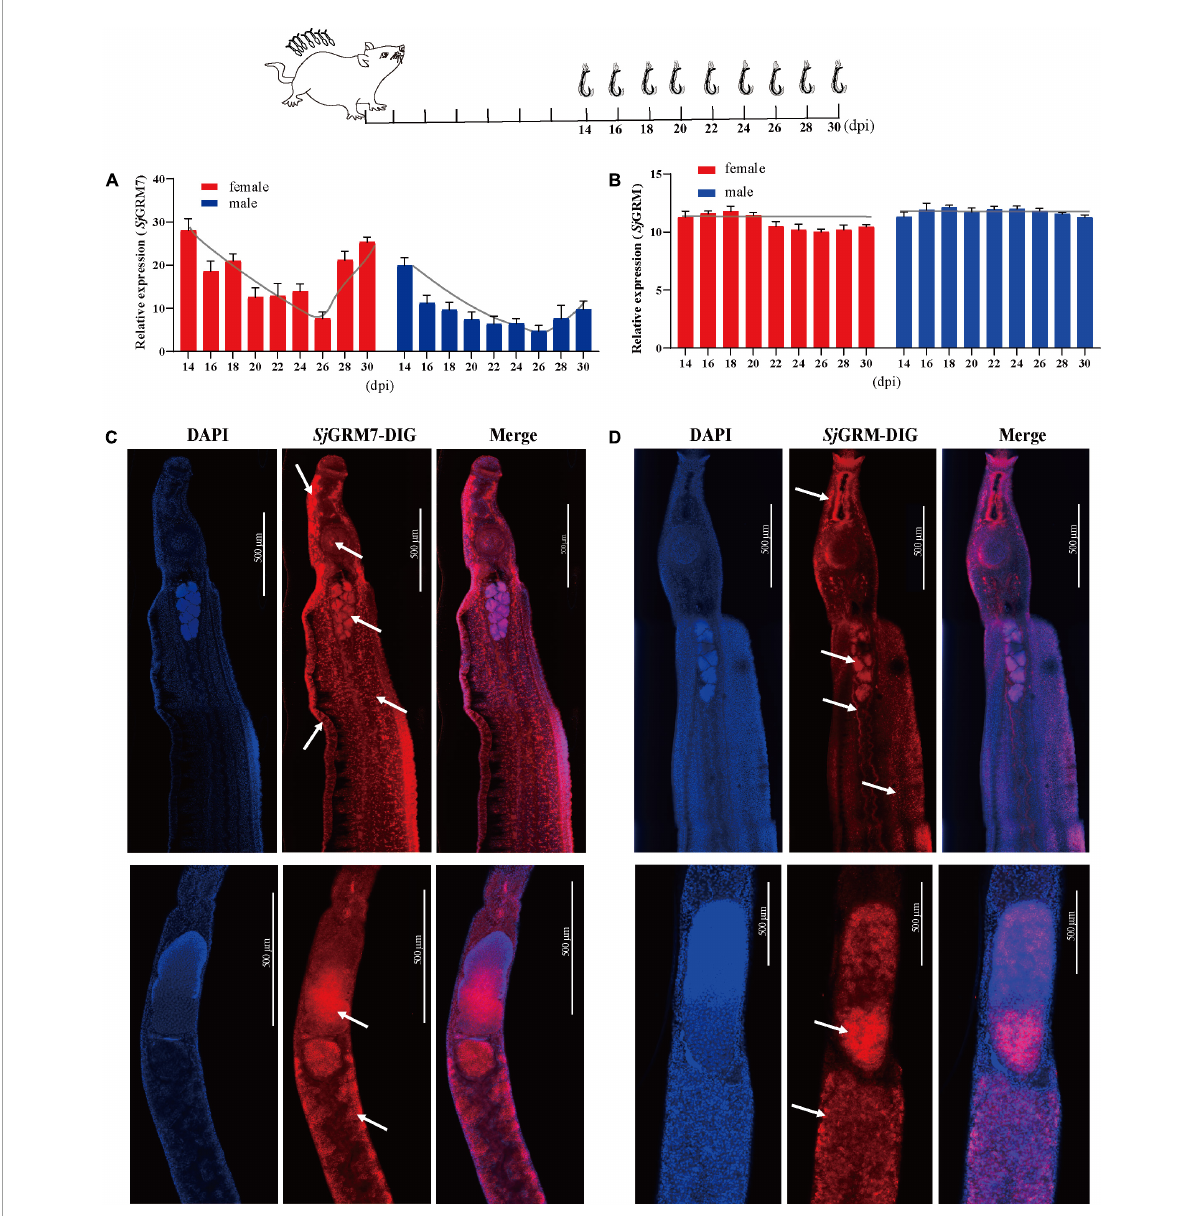
FIGURE2 Localization and expression of the two mGluRs in S. japonicum. The top is a flow chart of the samples collected during the different developmental periods and most worms in 14 and 16 dpi are not paired. (A) Expression patterns of Sj GRM7 at different time points post-infection. (B) Expression patterns of Sj GRM at different time points post-infection. (C) Sagittal confocal section of FISH showing Sj GRM7 mRNA enriched in the testes, brain ganglia, longitudinal neuraxis, ventral suckers, and peripheral nerve cells of a male worm (top) and in the ovaries and vitelline glands of a female worm (bottom) (white arrows). (D) Sagittal confocal section of FISH showing Sj GRM mRNA enrichment in the testes of male worms (top) and in the ovaries and vitelline glands of female worms (bottom). FISH analysis of the locations of the two S. japonicum mGluRs. Nuclei were stained blue (DAPI), and dig-labeled mGluRs were stained red. Fifteen parasites were used in the five experiments. Specific signals are indicated by white arrows. Scale bar: 500 µ m (C,D) . FISH, fluorescence in situ hybridization; mGluR and GRM, metabotropic glutamate receptor; DAPI, 4 (cid:48) ,6-diamidino-2-phenylindole.